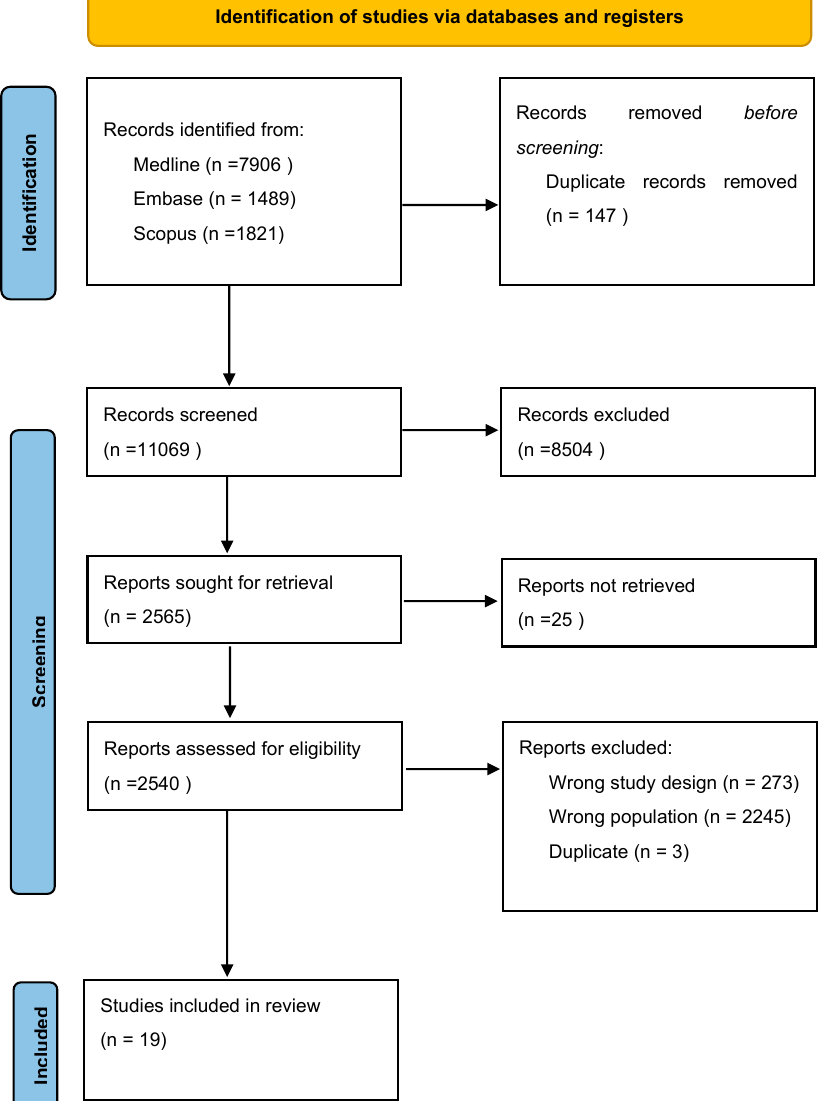
Figure 2. PRISMA diagram of selected studies.